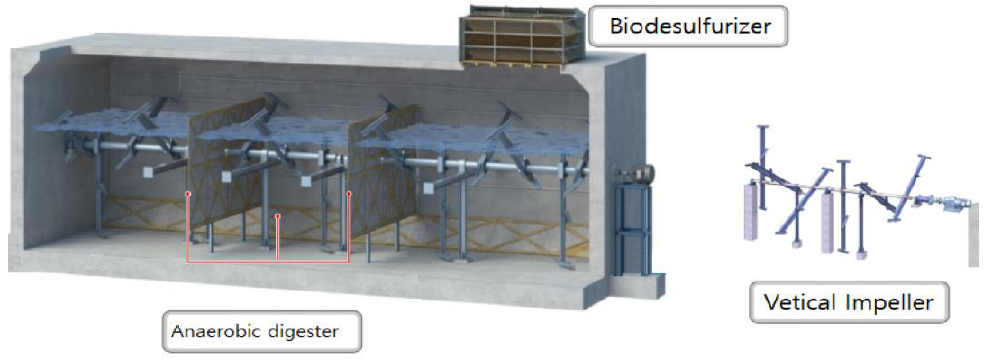
Figure 5. Anaerobic digester. From reference [30].